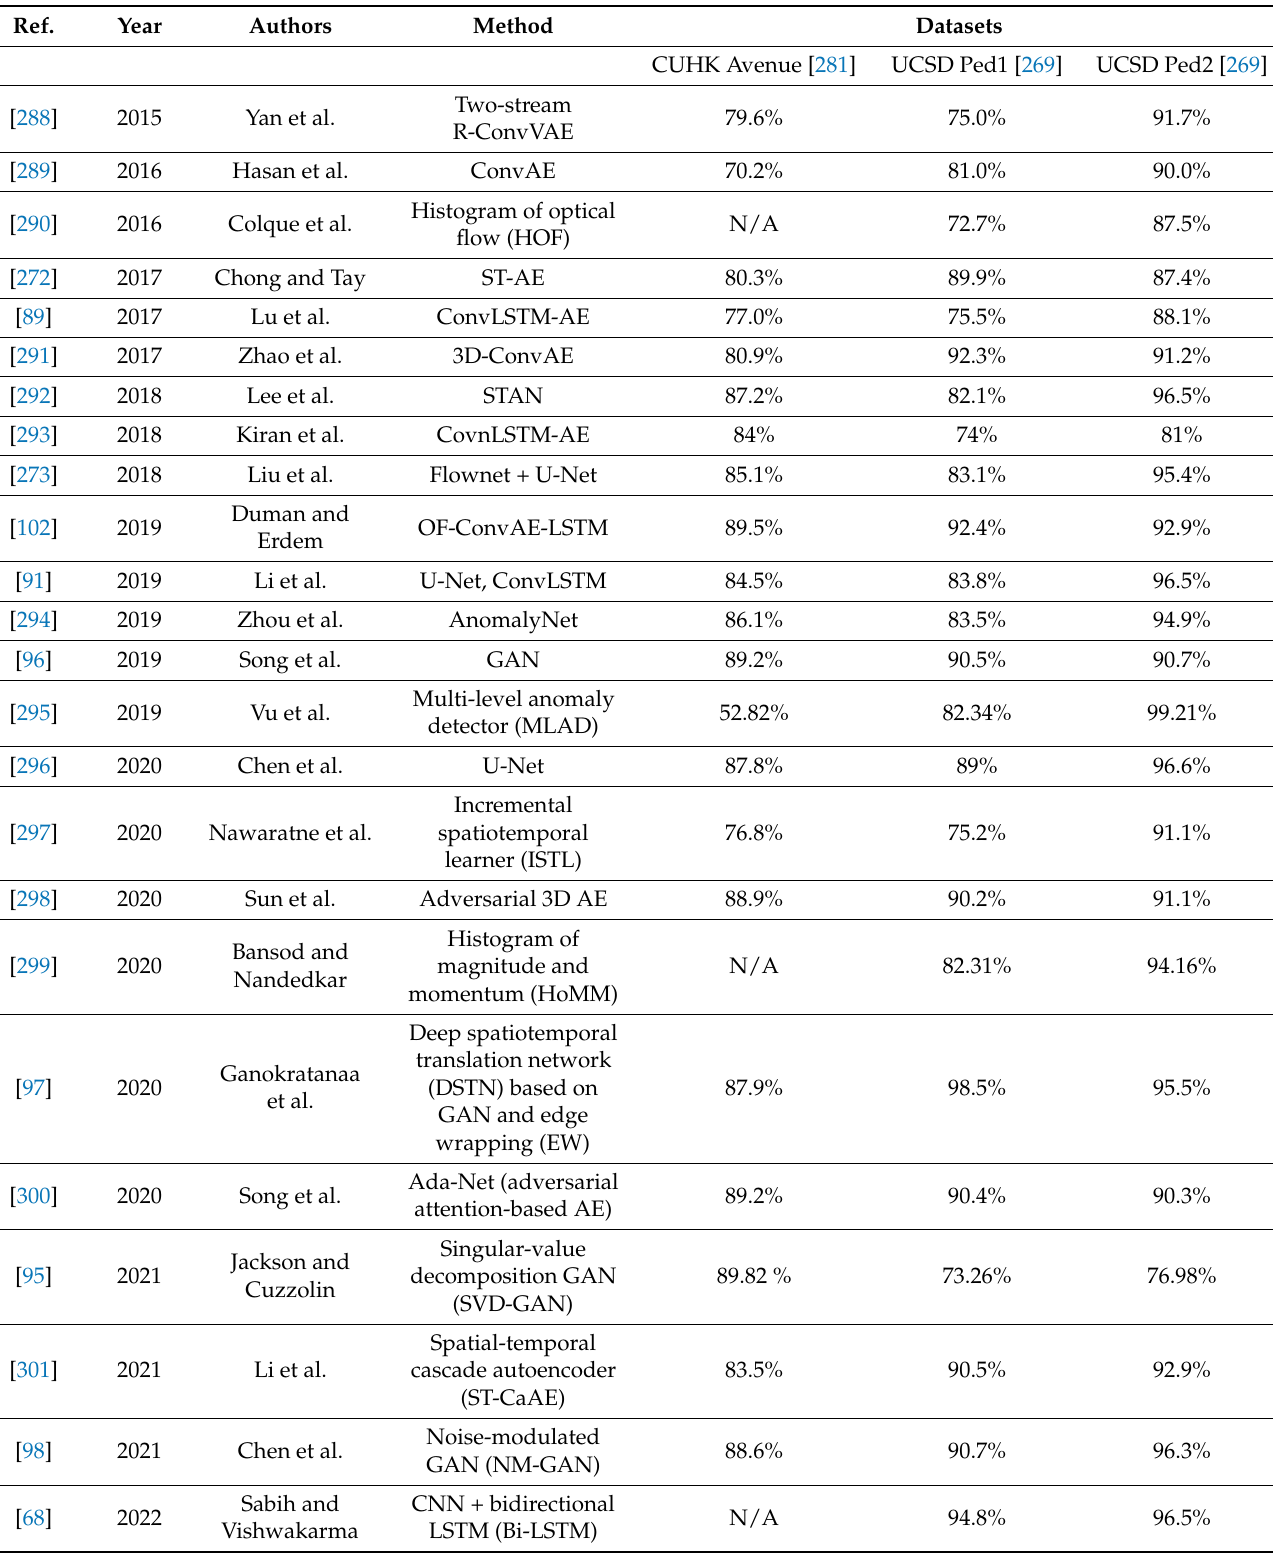
Table 9. Video Anomaly Detection Methods with CV